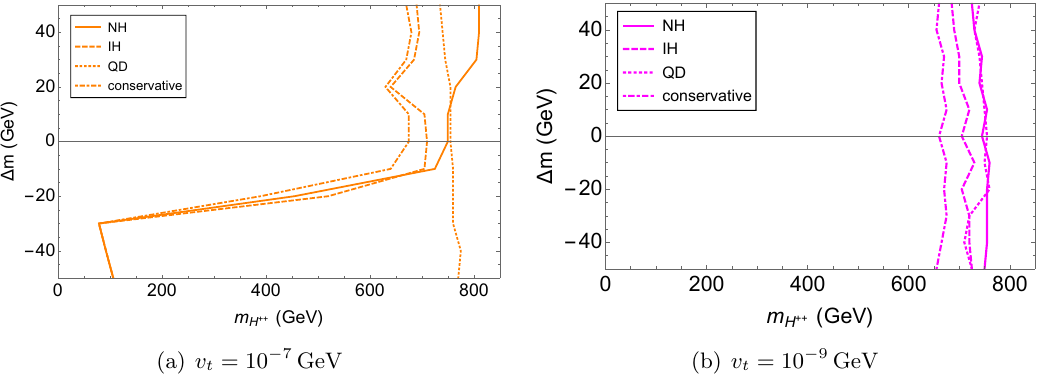
Figure 9 . The bounds for various neutrino mass cases. The region on the left of each line is